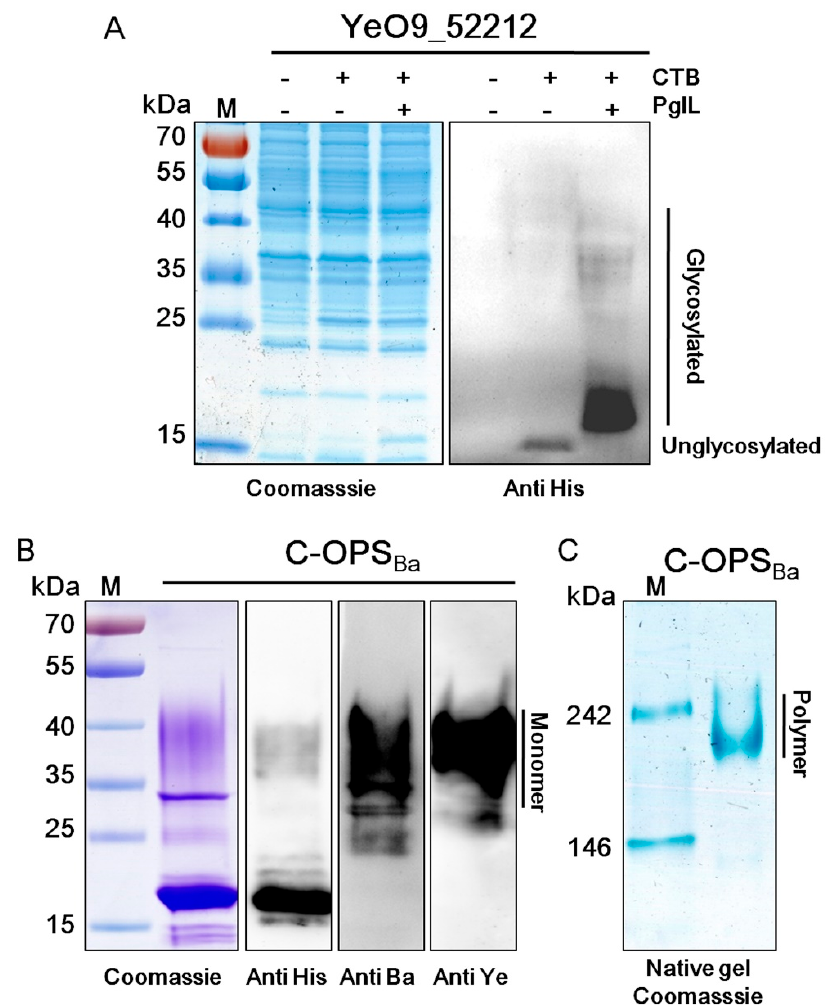
Figure 1. Analysis of glycosylated recombinant cholera toxin B subunit (rCTB) and CTB-OPS Ba expressed in YeO9_52212. ( A ) YeO9_52212 was transformed with pET-CTB4573H or pET-pglL-CTB4573H and then induced with IPTG. A wild type strain was treated in the same way (negative control). Coomassie Blue staining (left) and western blotting (right) were performed. ( B ) The CTB-OPS Ba (C-OPS Ba ) glycoprotein was purified from strain YeO9_52212 co-expressing PglL and rCTB. Samples were separated by 12% SDS-PAGE and analyzed by Coomassie Blue staining or western blotting using anti-His, anti- B. abortus (anti-Ba) or anti- Y. enterocolitica O:9 (anti-Ye) antibodies. ( C ) Coomassie Blue staining after native gel electrophoresis of C-OPS Ba .